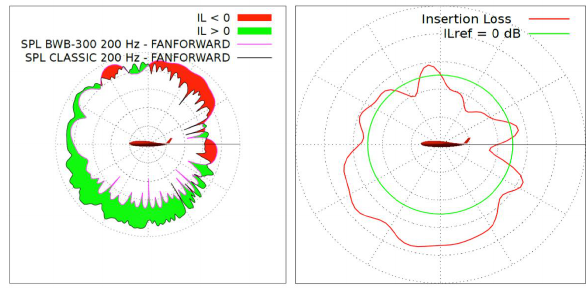
Figure 14: Superposition of the SPL directivity patterns due to fan noise on the BWB and classic concepts (left) and corresponding synthesized filter (right).